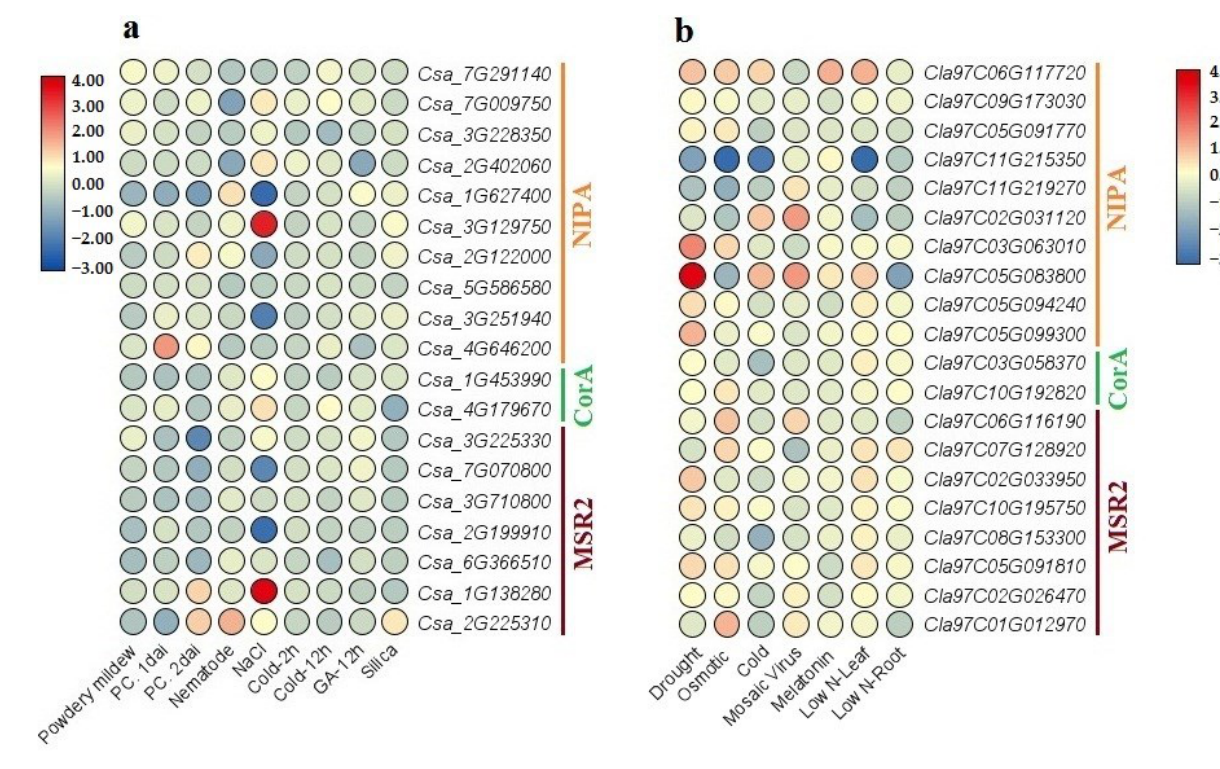
Figure 10. Heatmaps of expression of MGT genes respond to biotic and abiotic in C. lanatus ( a ) and C. sativus ( b ).